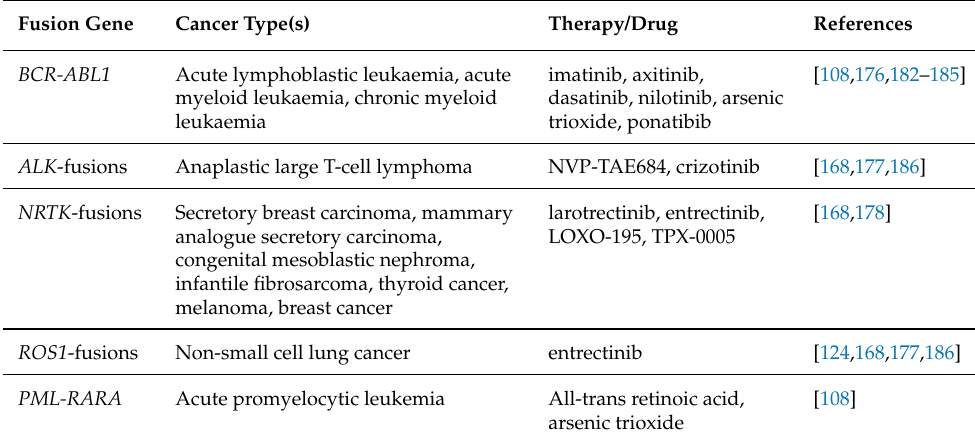
Table 2. List of therapeutically-targeted fusion